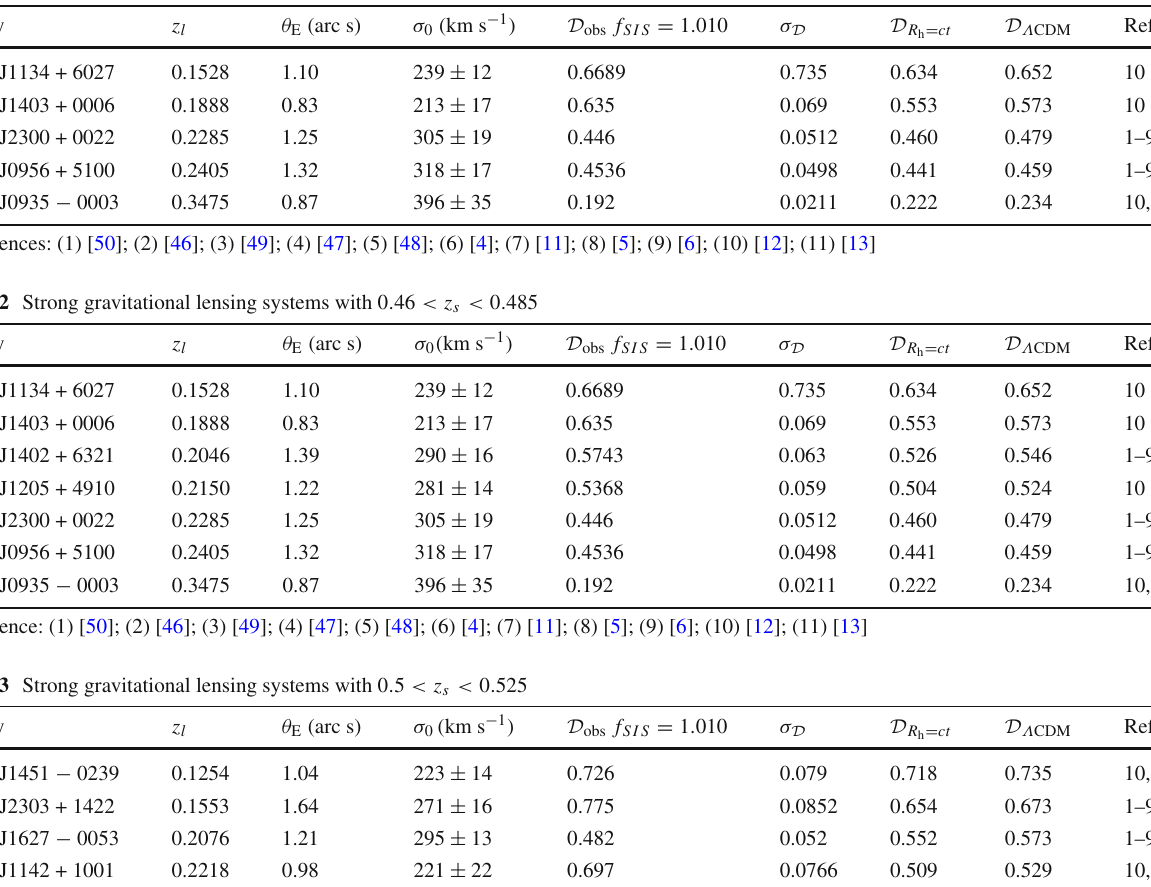
Table 1 Strong gravitational lensing systems with 0 . 45 < z s < 0 . 475